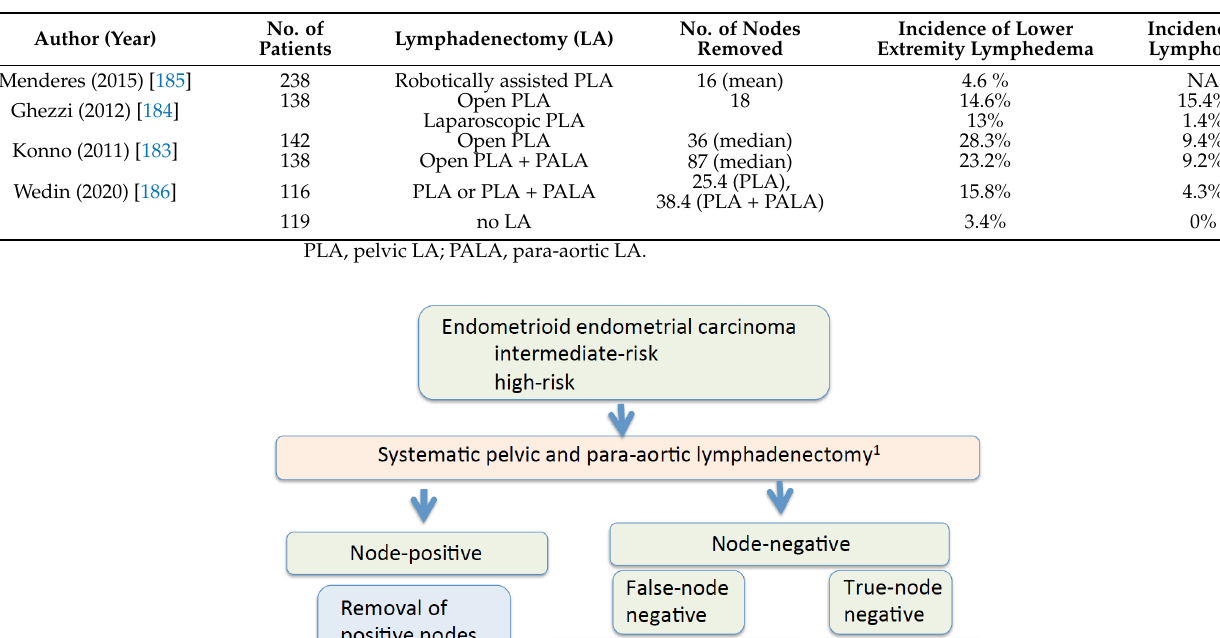
Table 4. Incidence of lower extremity lymphedema and lymphocele in patients with endometrial cancer.